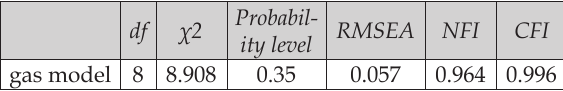
Table 6. Model fit Indices of per-capita gas consump -